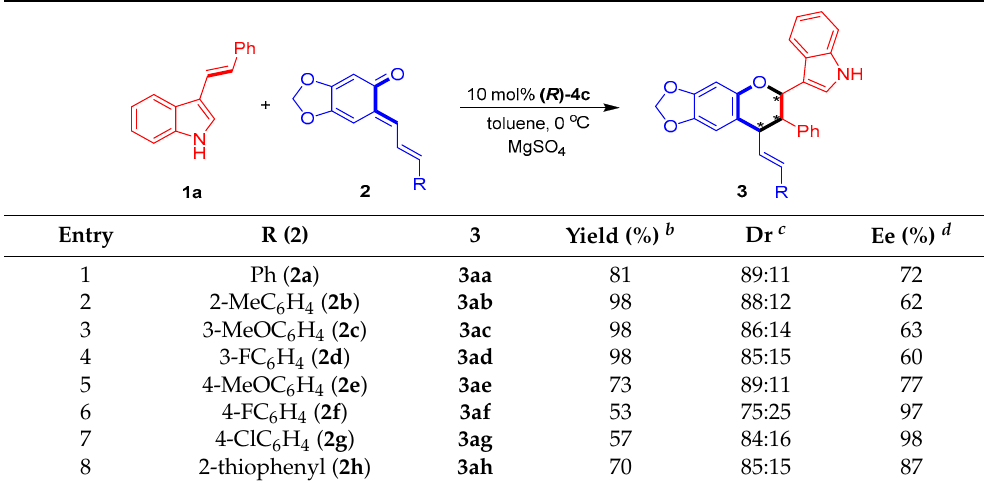
Table 4. Substrate scope of o -QMs 2 a .